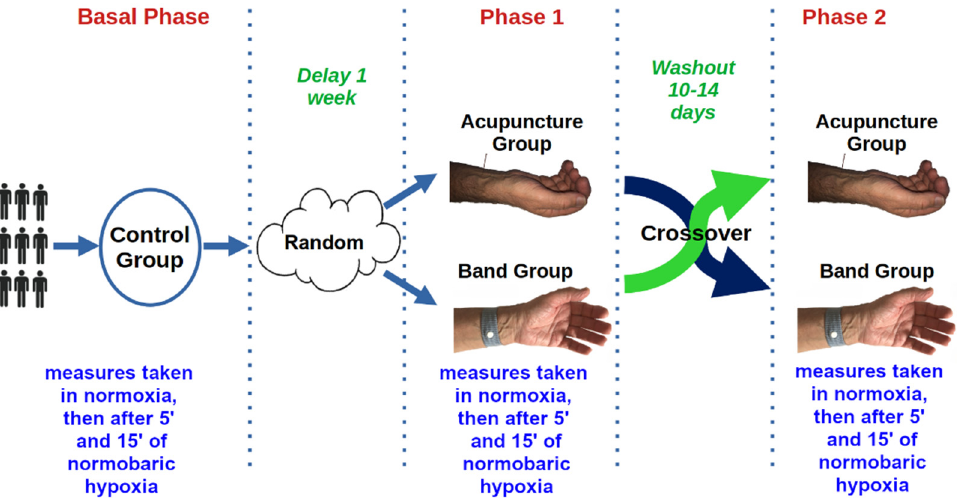
Figure 2. Main flow of the study.